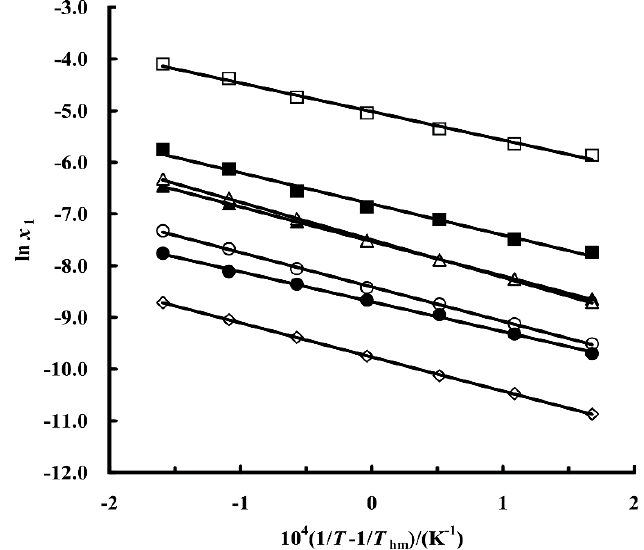
) n -butanol; ( ) ethyl acetate; (cid:35)